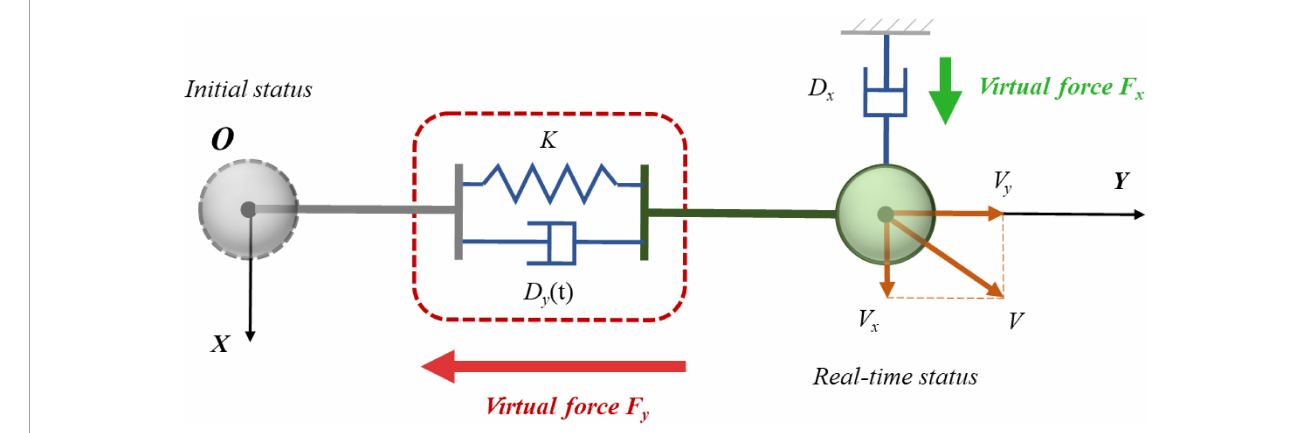
FIGURE4 Schematic diagram of three-dimensional impact resistance of the load.